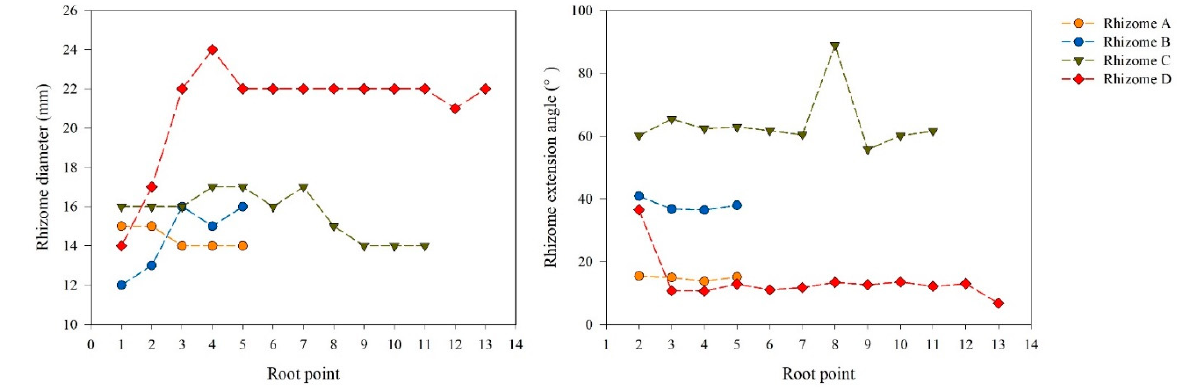
Figure 7. Variation in rhizome diameter and extension angle as a function of the root point. The x -axis represents the n th root point of the rhizome. The angle between the line formed by the candidate root point, starting root point, and x -direction is defined as the extension angle.